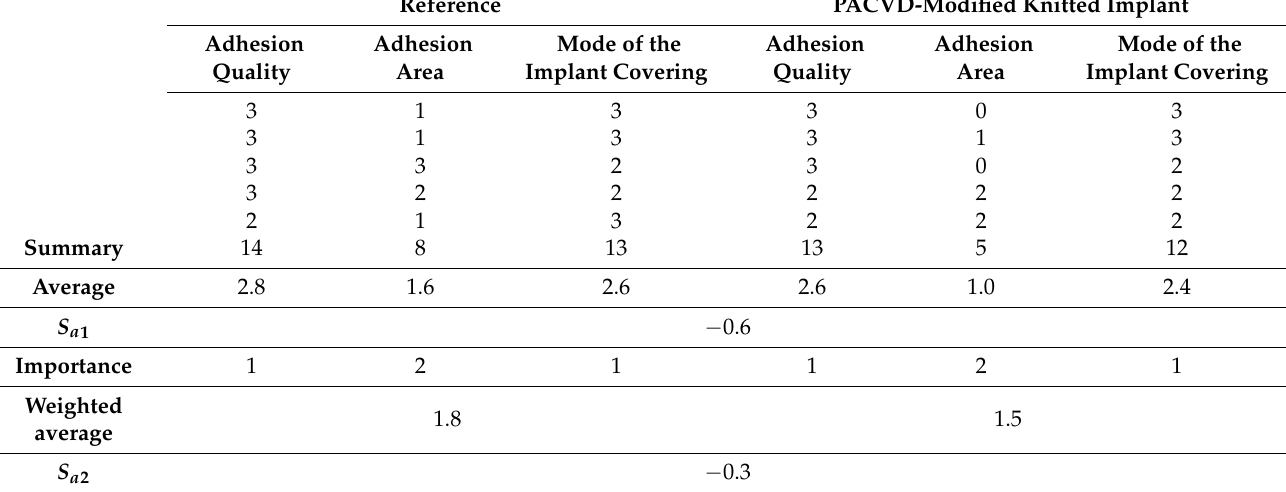
Table 7. Semi-quantitative, macroscopic evaluation of the adhesion susceptibility of the PACVD- modified implants in relation to the reference (unmodified by PACVD) sample after 12 weeks of the intra-abdominal